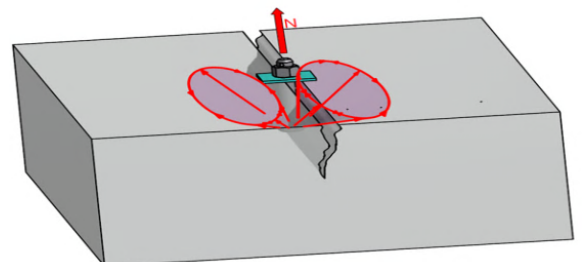
Figure 6. Stress distribution in cracked concrete due to splitting.